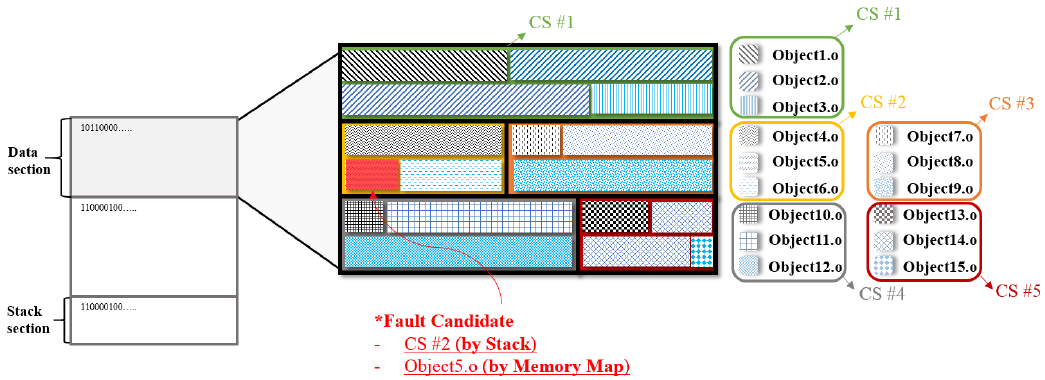
Figure 4. Example of memory partitioning by memory map and stack.